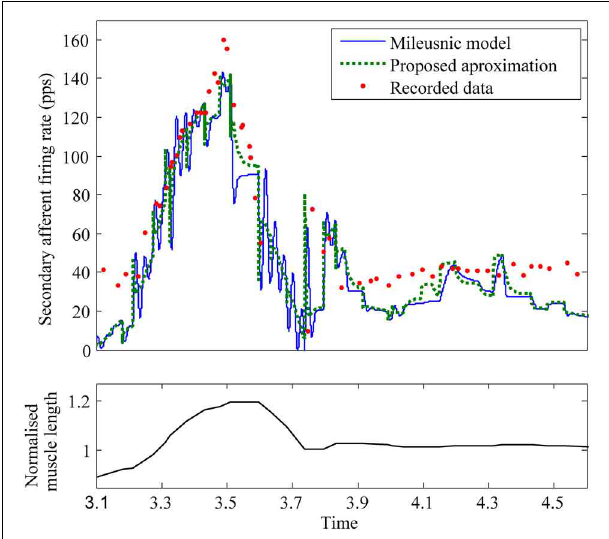
FIGURE 7 | Comparison of Mileusnic modeled data and proposed approximation against recorded data from a cat (Figure 4A of Prochazka et al., 1979). Fusimotor activity was assumed to be absent.